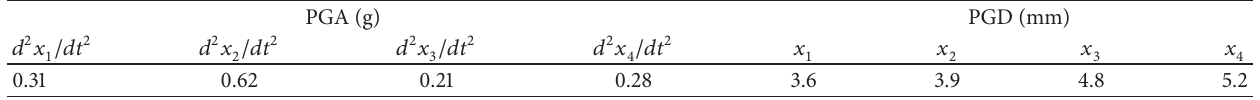
Table 5: PGA and PGD values of mathematical model.